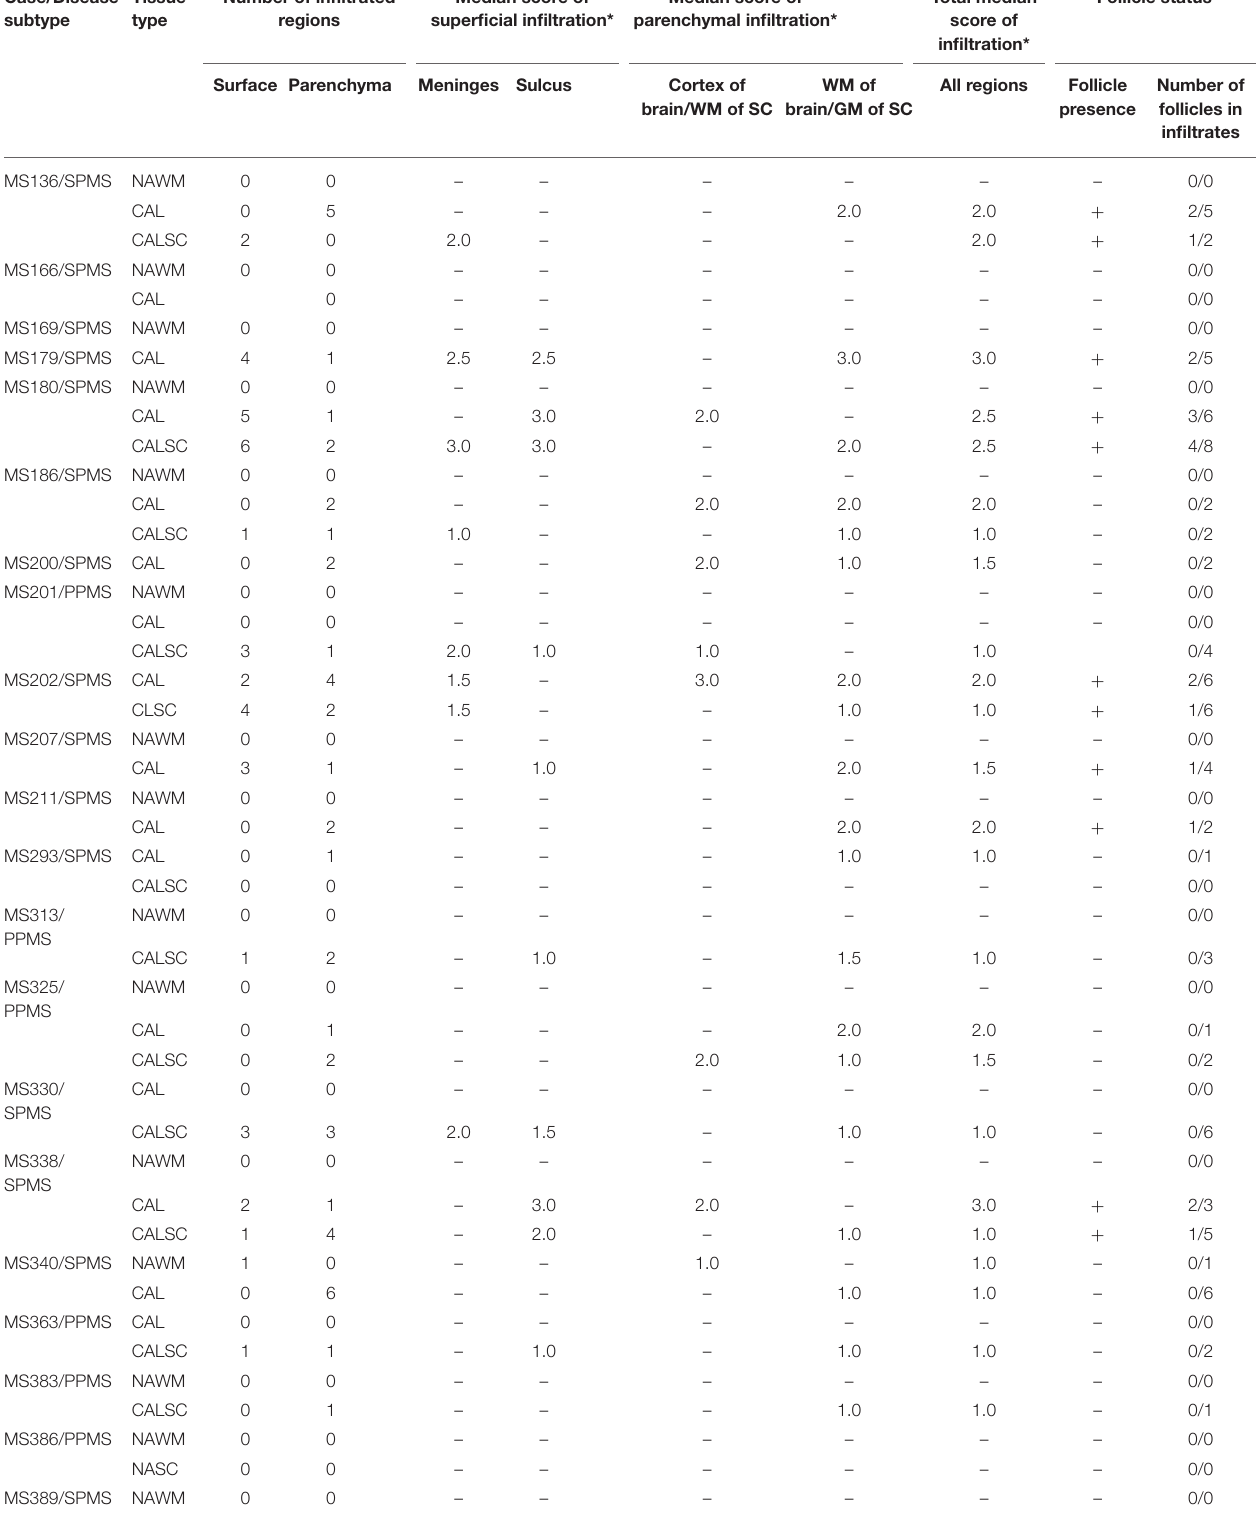
TABLE 1 | Tissue characterization, infiltration and follicle status in brain and spinal cord of progressive multiple sclerosis, Parkinson’s disease, and healthy control cases. Case/Disease